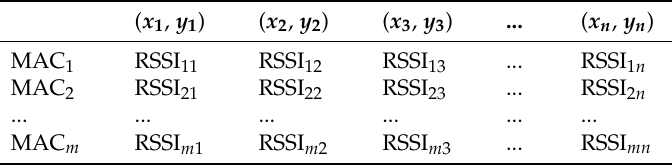
Table 1. Format of the Wi-Fi fingerprint